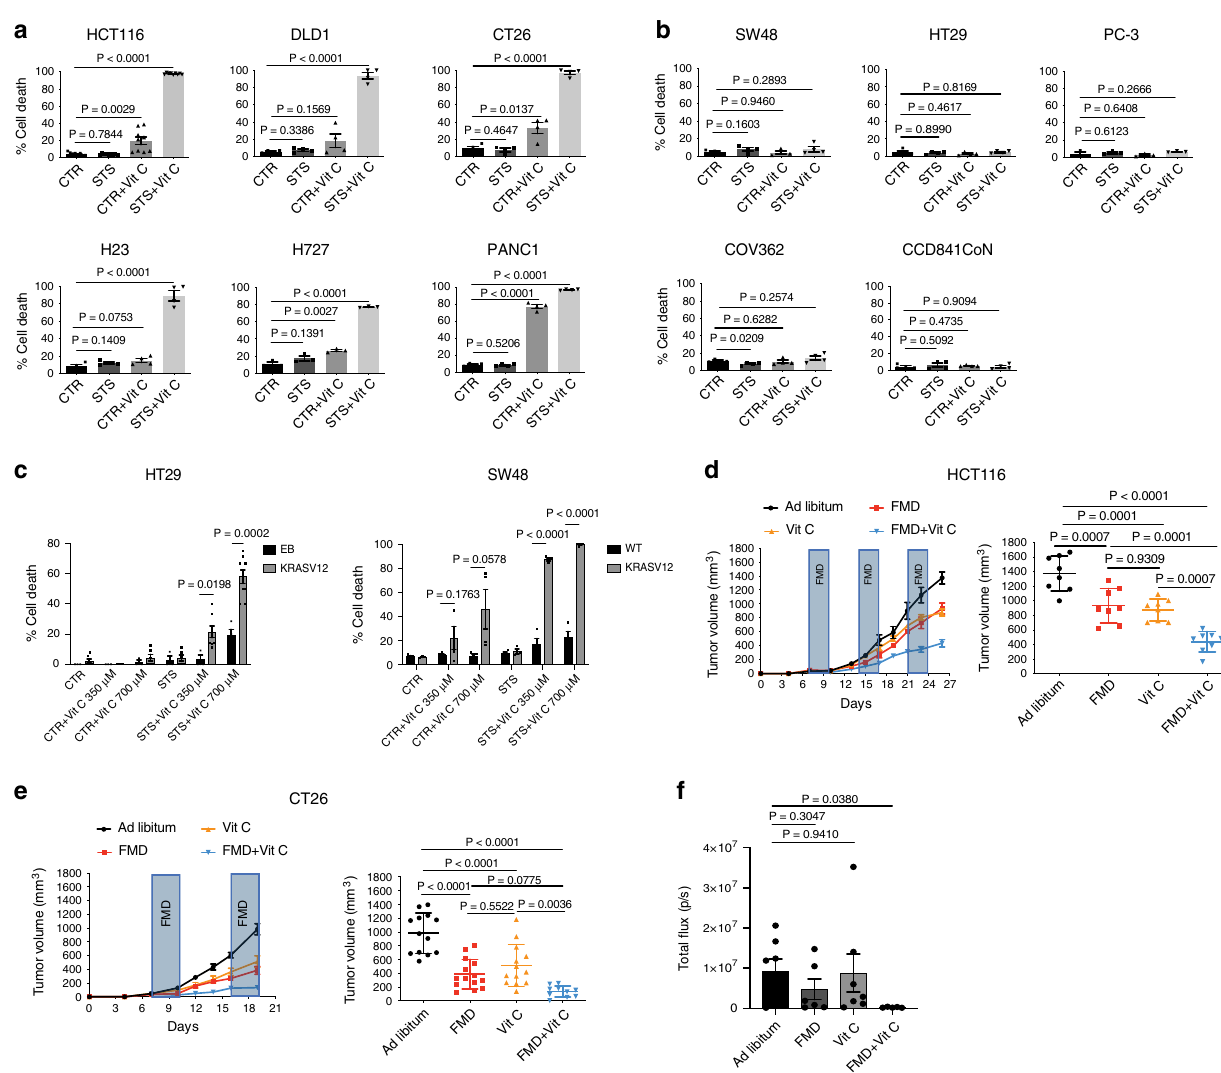
Fig. 1 FMD/STS enhances vitamin C anticancer activity in KRAS -mutant tumors. a Viability of KRAS -mutant and b KRAS -wild-type cancer cells treated for 48 h with STS with or without vitamin C; HCT116 ( n = 9); DLD1, CT26, H23, and PANC1 ( n = 4); H727 ( n = 3); SW48 and HT29 ( n = 4); PC-3 ( n = 3); COV362 and CCD841CoN cells ( n = 4). P values were determined by two-sided unpaired t -test. DLD1: exact P value = 0.0000005; CT26: exact P value = 0.00000009; H23: exact P value = 0.00001; H727: exact P value = 0.000005; PANC1: exact P values = 0.0000001 (CTR vs CTR + Vit C), 0.00000000004 (CTR vs STS + Vit C). c Viability of HT29 cells infected with empty backbone (EB; n = 3, n = 4 in STS + Vit C 700 µ M) or KRASV12 vector ( n = 6, n = 7 in STS + Vit C 125 µ M, n = 8 in CTR + Vit C 700 µ M and STS + Vit C 350 µ M, n = 9 in STS + Vit C 700 µ M); SW48 WT ( n = 4) and SW48 KRASV12 ( n = 4, n = 3 in CTR and STS) treated for 48 h with STS with or without vitamin C. P values were determined by two-sided unpaired t